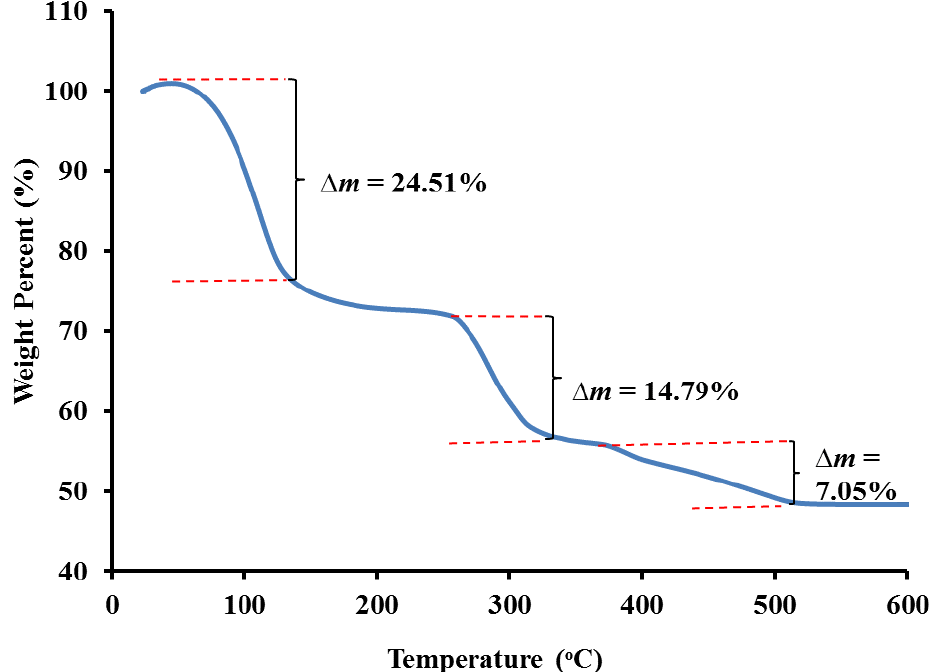
Figure 5. TGA curve of the pure CMC from kenaf bast